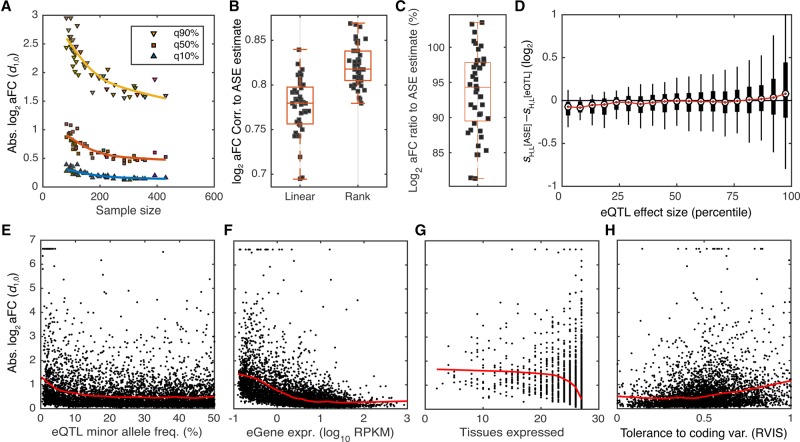
Empirical properties of the aFC distributions in GTEx data. All aFC values are calculated with the nonlinear approximation method (M3). (A) Distribution of absolute log2 aFC across tissues as a function of sample size. Each point represents a tissue in GTEx data, and 90%, 50%, and 10% quantiles of absolute aFC across a tissue are shown. (B,C) Correlation of log2 aFC estimates (B), and the ratio of the estimates (C) derived from eQTL and ASE data. Each point corresponds to one GTEx tissue. (D) Difference between the aFC estimates from allelic expression (sASE) and eQTL (seQTL) as a function of absolute average aFC (|sASE+
seQTL|/2), with H and L referring to higher and lower expressed alleles of each eQTL in adipose subcutaneous, respectively. Estimated effect size form ASE data tend to be smaller in weak eQTLs and larger for stronger eQTLs as compared to those derived using eQTL data. (E–H) Distribution of absolute log2 aFCs calculated from GTEx adipose subcutaneous as function of minor allele frequency (E), gene expression level (F), number of tissues where the gene is expressed >0.1 RPKM in 10 or more individuals (G), and logistic-transformed RVIS, a measure of each gene's tolerance to variation in the coding region (H) (Petrovski et al. 2013). Red line shows fit by robust locally weighted scatterplot smoothing.